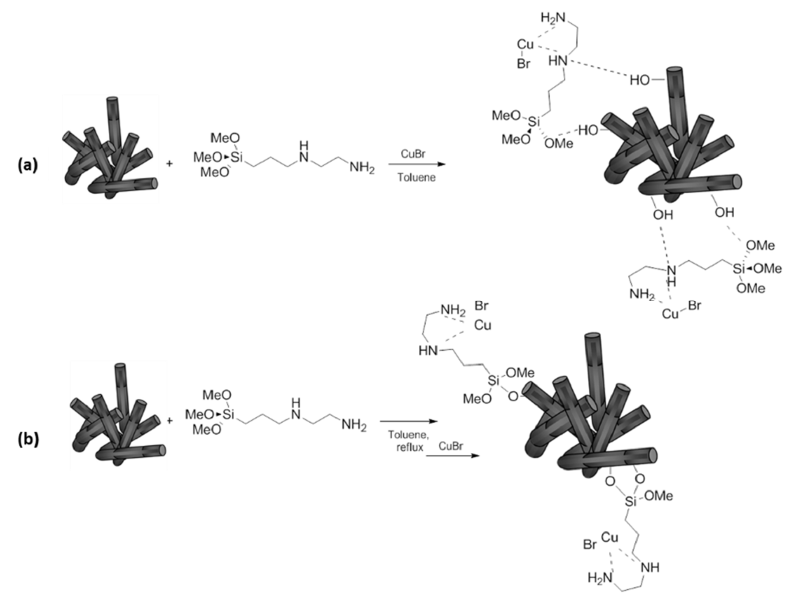
Figure 3. ( a ) Physisorption of CuBr/silane catalyst onto HNTs; ( b ) modification of HNTs surface by silane groups before to formation of the catalyst. Adapted with permission from ref.